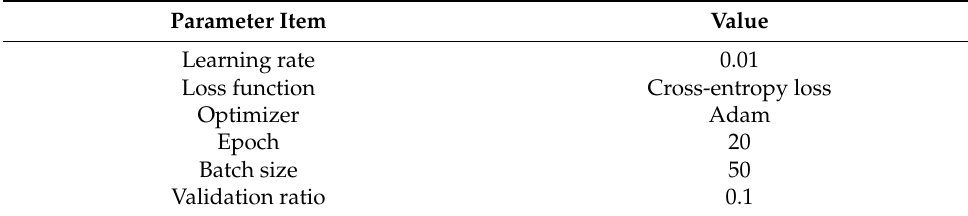
Table 4. The relevant parameter settings for LSTM network.